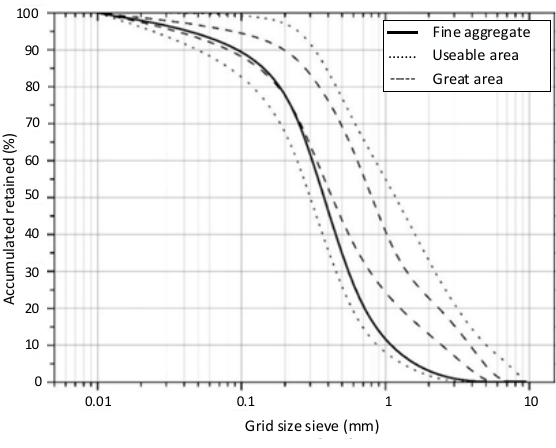
Figure 1. Distribution according to fine aggregate sieve.